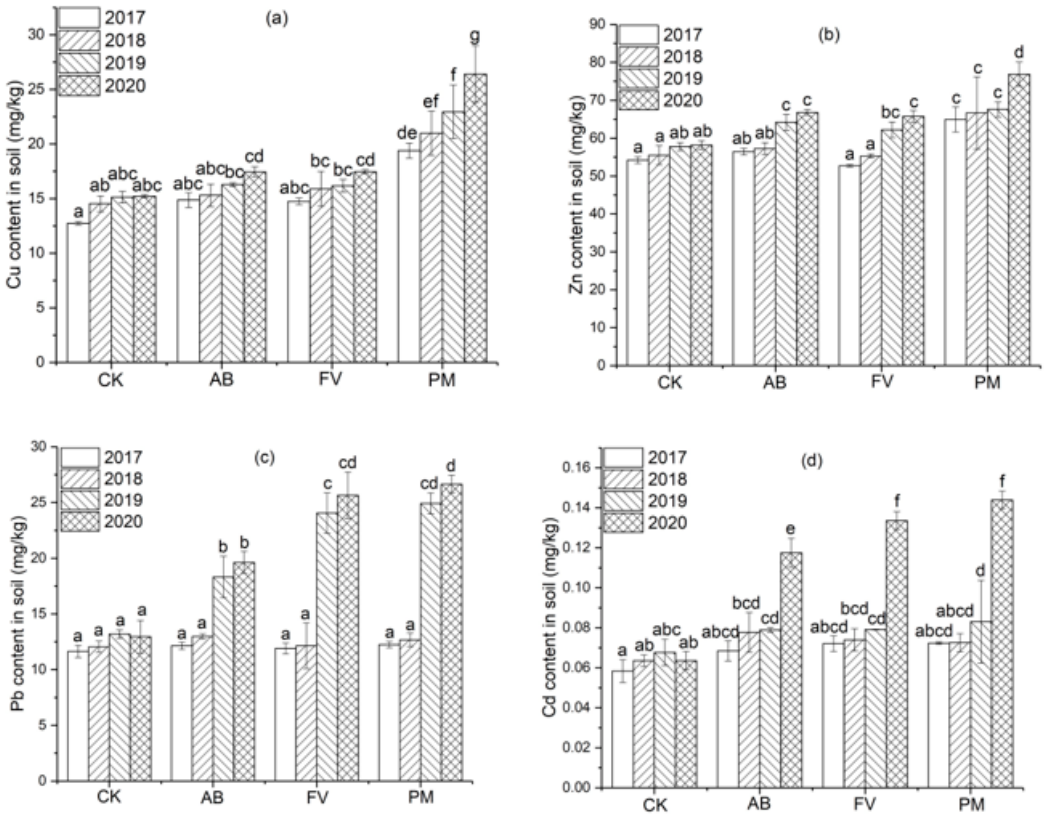
Figure 6. ( a ) Cu content in the soils by the different fertilizer treatments during the four experimental years; ( b ) Zn content in the soils by the different fertilizer treatments during the four experimental years; ( c ) Pb content in the soils by the different fertilizer treatments during the four experimental years; ( d ) Cd content in the soils by the different fertilizer treatments during the four experimental years. Data are expressed as means ± SD; n = 3. Different letters on data in the same group indicate a significant difference between them at p < 0.05 level.